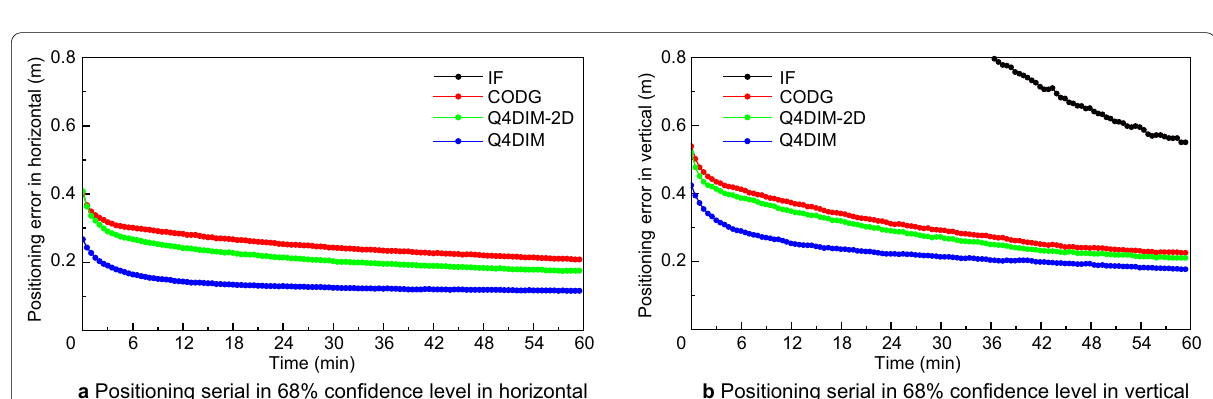
Fig. 11 Single frequency PPP convergence serial for DOY 001–030, 2020, respectively. While for different ionospheric delay processing mode with IF, CODG, Q4DIM‑2D and Q4DIM, the results are denoted in black, red, green, and blue, respectively